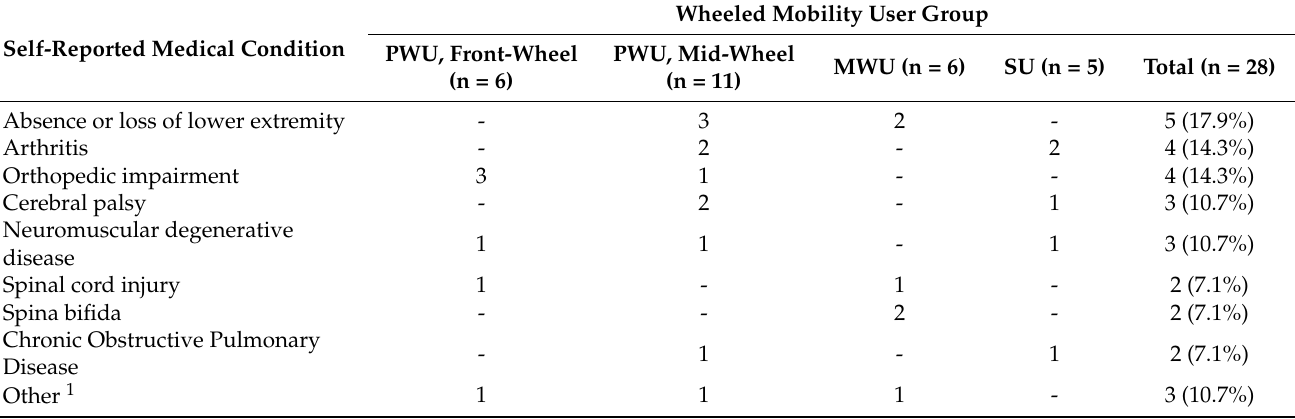
Table 2. Primary medical condition reported by participants (n = 28) affecting physical mobility stratified by type of mobility device